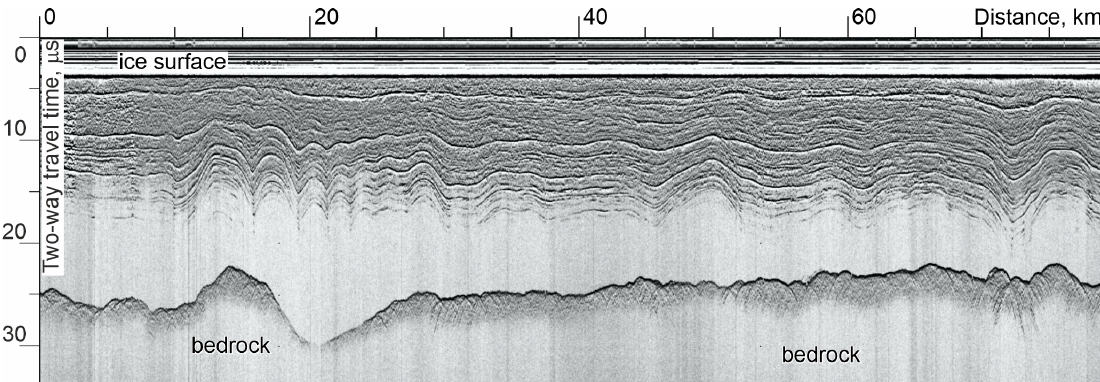
Figure 3. Radio-echo time-section along the flight line 59008